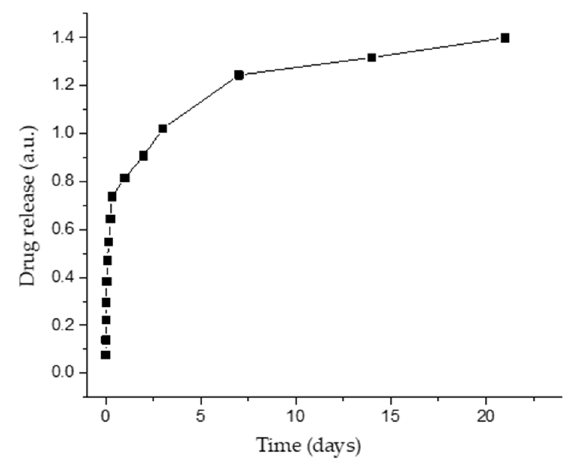
Figure 8. Drug release as function of time from BG+CIPRO/PMMA coatings .